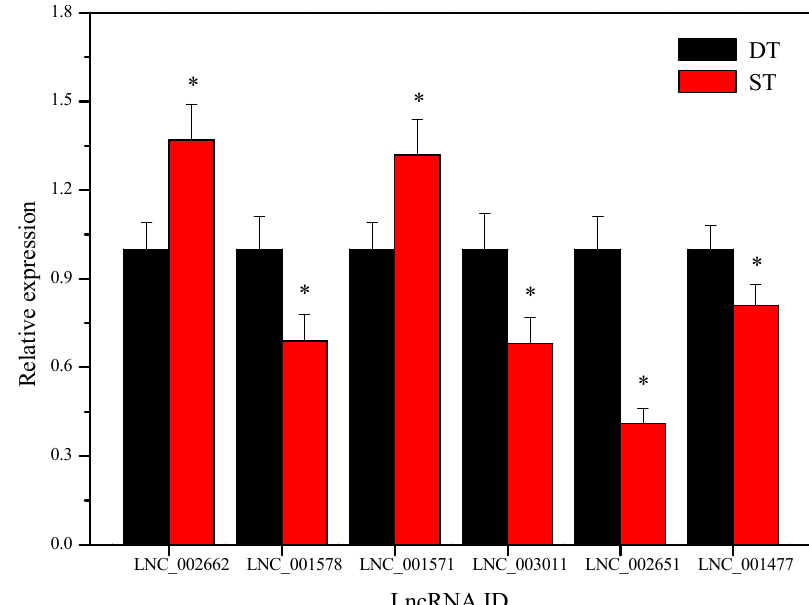
Figure 6. The verification of the expression level of the six differentially expressed lncRNAs (LNC_002662, LNC_001578, LNC_001571, LNC_003011, LNC_002651, and LNC_001477) between potato dormant tubers (DTs) and sprouting tubers (STs) by using qRT-PCR. The qRT-PCR data are represented as the mean ± standard deviation (SD). Columns with the asterisk (*) are significantly different at p < 0.05.